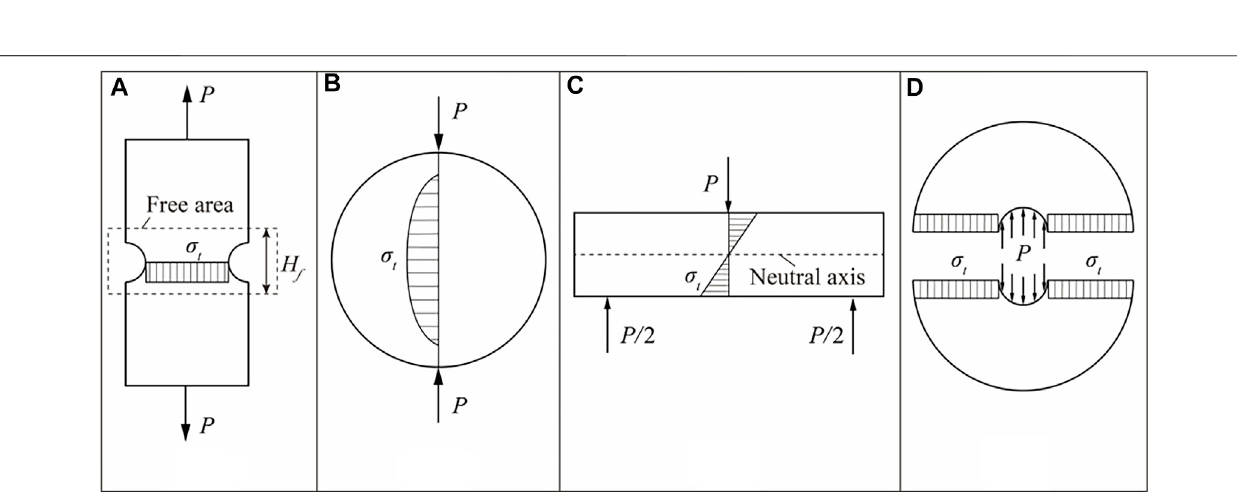
Frontiers in Earth Science |